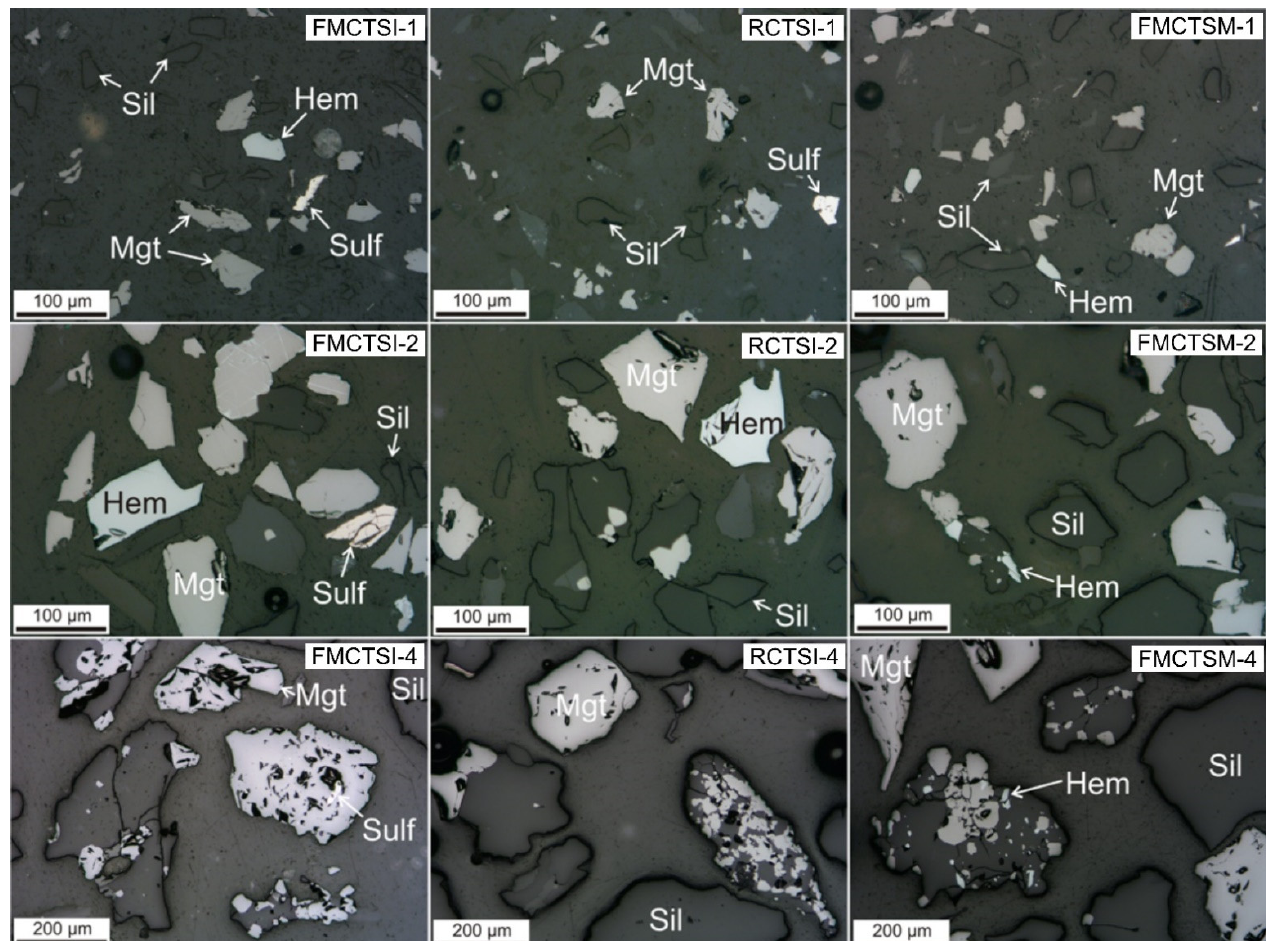
Figure 6. Liberated minerals and aggregates in the final product of the studied samples crushing. The upper right corner is the polished section’s name (see Table 7). Reflected polarized light.